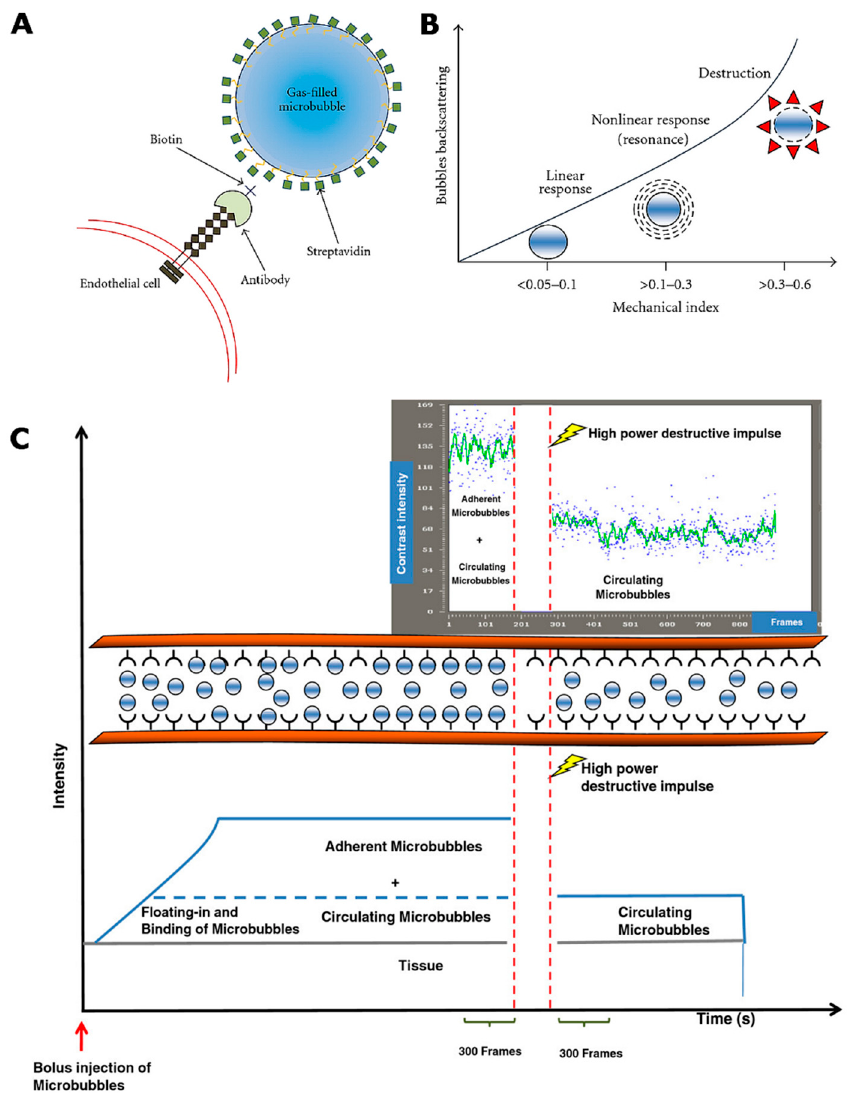
Figure 4. Molecularly targeted microbubbles. ( A ) Selective binding to sites of molecular expression on the endothelium: streptavidine is used for attachment of biotinylated ligands onto the shell of ultrasound contrast microbubbles; ( B ) At very low acoustic power, microbubbles oscillate in relatively symmetrical order, backscattering at the same frequency of incident ultrasound. At a slightly higher mechanical index, microbubbles oscillate in a nonlinear manner (nonlinear response), backscattering a variety of frequencies (harmonic). Higher acoustic pressures destroy the microbubbles with a high-intensity backscatter response; ( C ) Time course analysis of signal intensity before and after high-power destructive pulse and diagram representation of destructive methodology. After intravenous administration, targeted microbubbles can bind to specific antigens expressed on endothelial cells of tumor vessels (orange), whereas others remain in the vessel lumen, freely circulating. After a high-power destructive pulse (red dotted lines), both bound and circulating microbubbles are destroyed, following circulating microbubbles that arrive from outside of the scan plane, which remain freely circulating for several seconds. Contrast intensity is the sum of the intensity from the tissue, intensity from the circulating microbubbles and intensity from the microbubbles bound to receptors on endothelial cells. After digital subtraction of the video intensity calculated on 300 predestruction frames from video intensity calculated on 300 postdestruction frames, the resulting video intensity is due only to bound microbubbles. (Reprinted from Reference [207]. Copyright with permission from ©